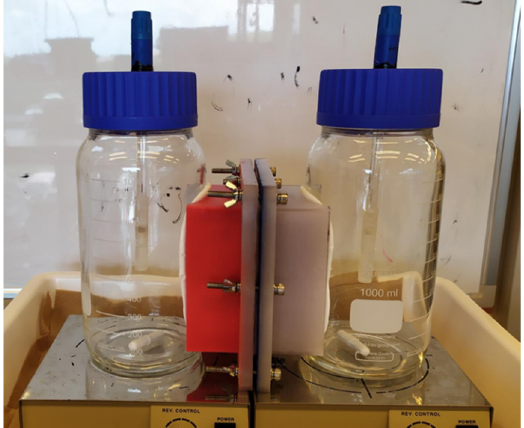
Figure 4. A photograph of the two-chambered device constructed for permselectivity measurement. Each chamber harbors a reference electrode. The chambers are separated by the AEM either produced in this study or commercial AMI-7001.